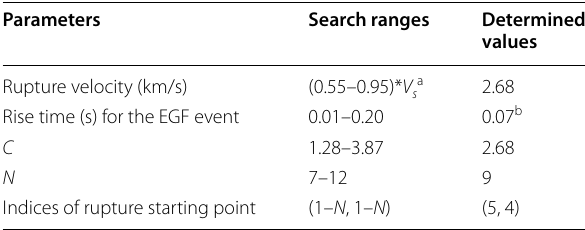
Table 2 Parameters related to synthesizing ground motions by the EGFM